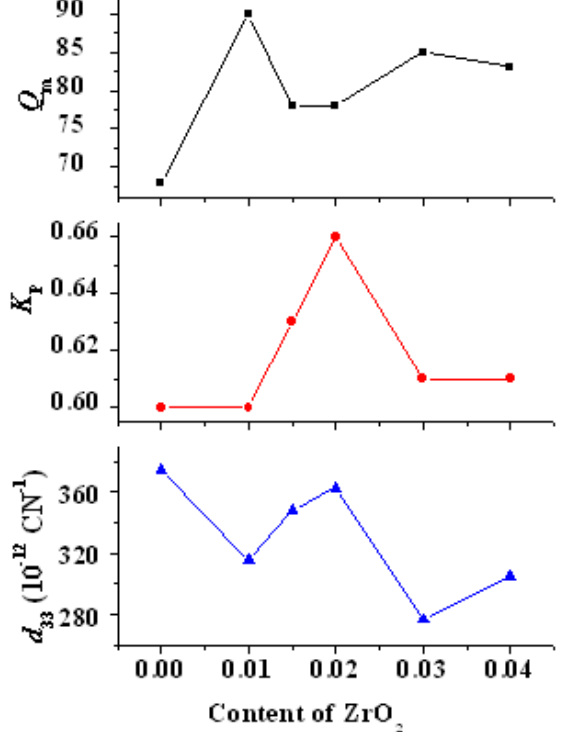
Figure 13. Variations in d 33 , K p , and Q m with ZrO 2 content in PZTN ceramics.